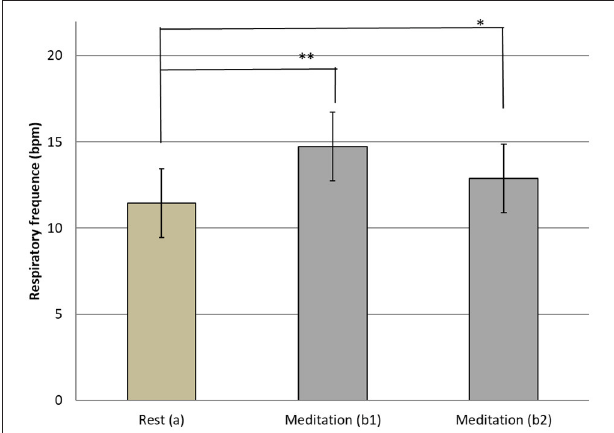
FIGURE 3 | Linear correlation between respiratory rate and depth of mediation ( ρ = 0.9685, p =